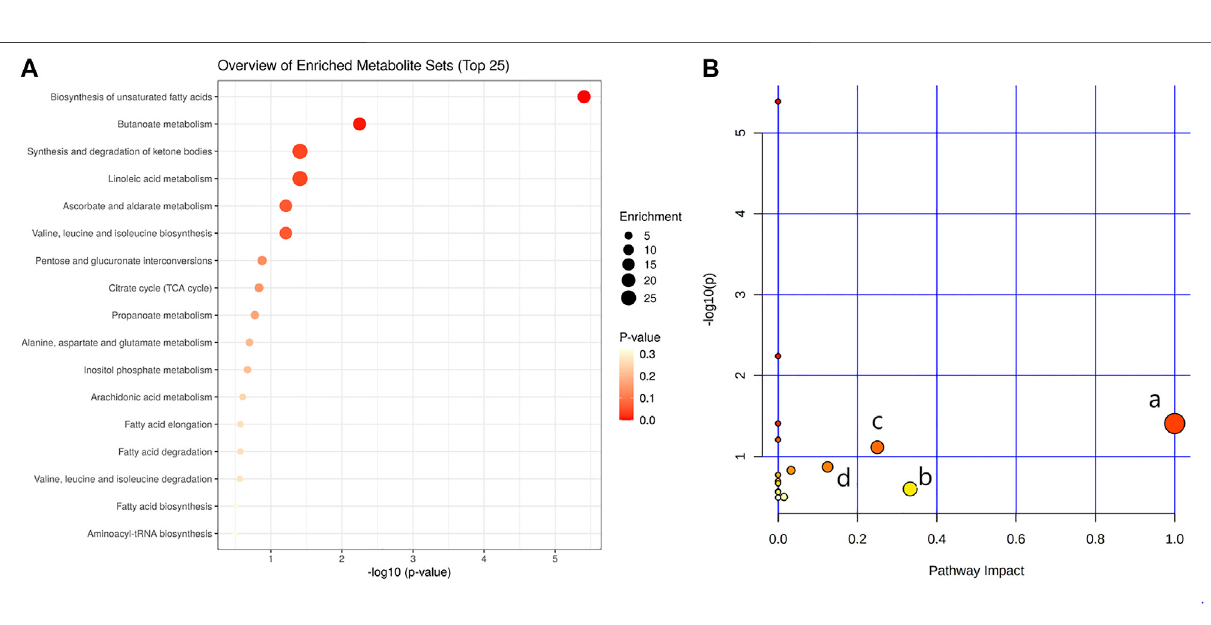
Frontiers in Pharmacology |